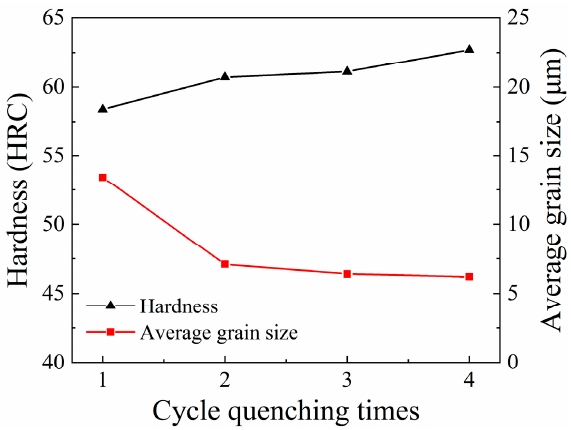
Figure 13. Relationship among hardness, average grain size and cyclic quenching times .